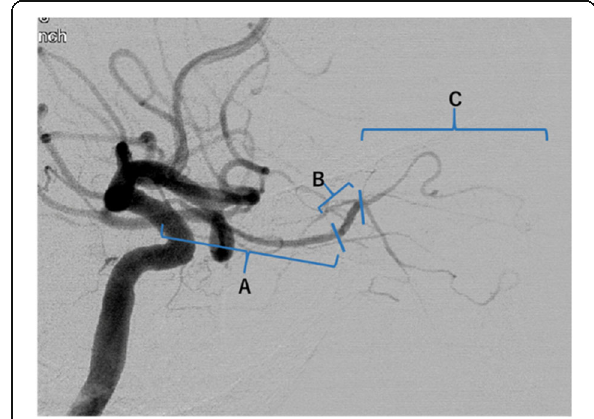
Fig. 4 Segmentation of the ophthalmic artery. a First portion b Second portion c Third